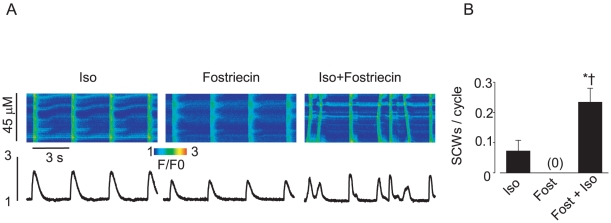
Inhibition of PP2A promotes spontaneous Ca2+ release under condition of β-adrenergic stimulation.A, Representative line-scan images and temporal profiles of Rhod-2 fluorescence recorded in control myocyte treated with 100 nM Iso alone, 300 nM fostriecin (30 min preincubation), a specific PP2A inhibitor, alone, and 300 nM fostriecin plus 100 nM Iso, respectively. Cells were field-stimulated at 0.3 Hz. B, Frequency of diastolic SCWs was calculated for myocytes treated with Iso alone (n = 12), fostriecin (Fost) alone (n = 11), and Fost plus Iso (n = 11). *, p<0.05 Fost plus Iso vs. Iso alone; †, p<0.05 Fost plus Iso vs. Fost alone.